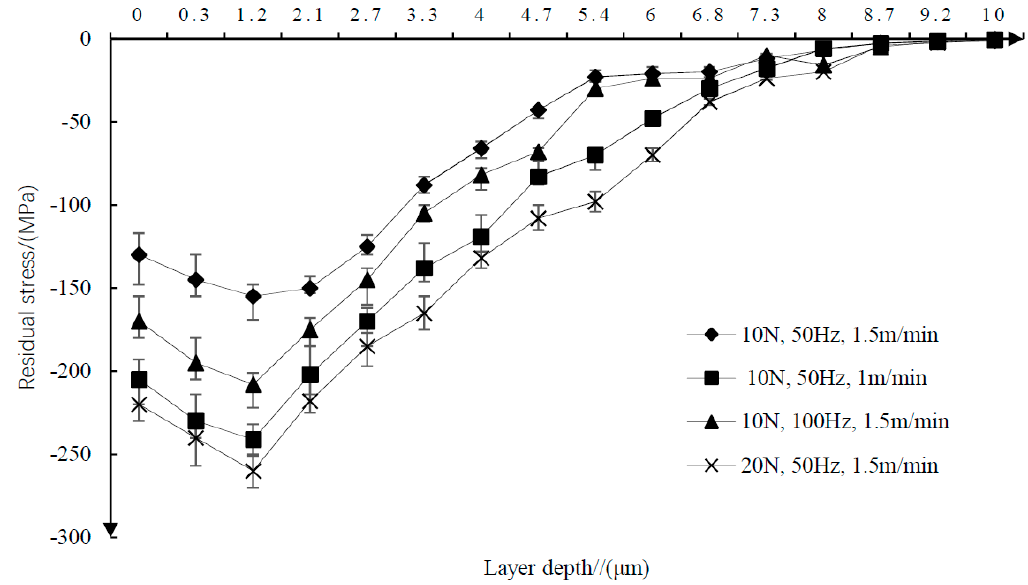
Figure 4. Layer depth of residual stress .